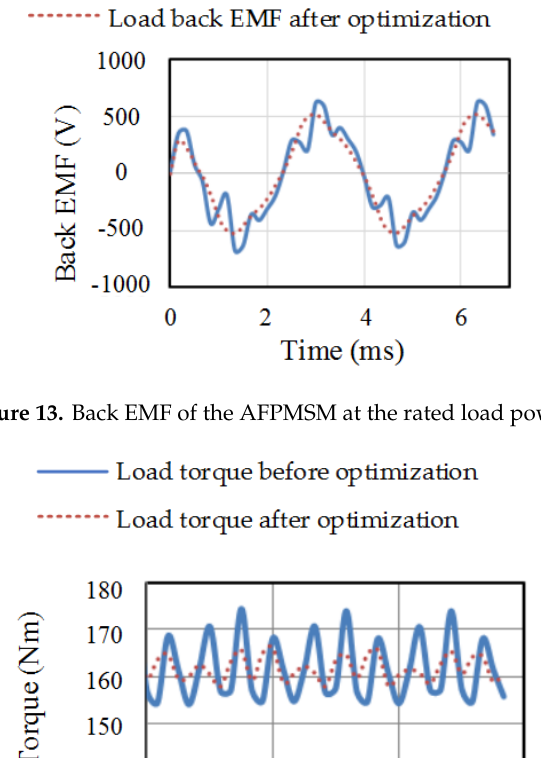
Figure 13. Back EMF of the AFPMSM at the rated load power.